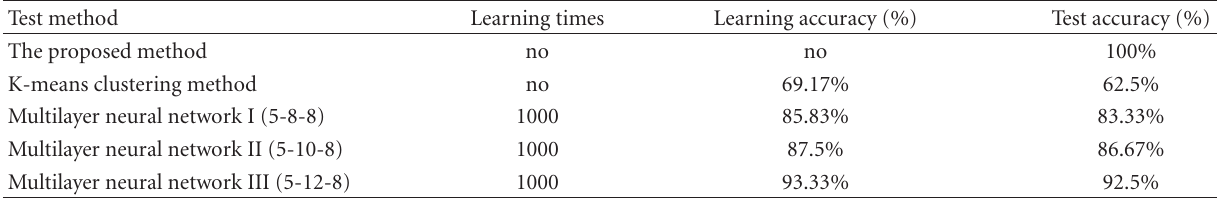
Table 4: The results of the fault diagnosis by day in di ff erent ways.